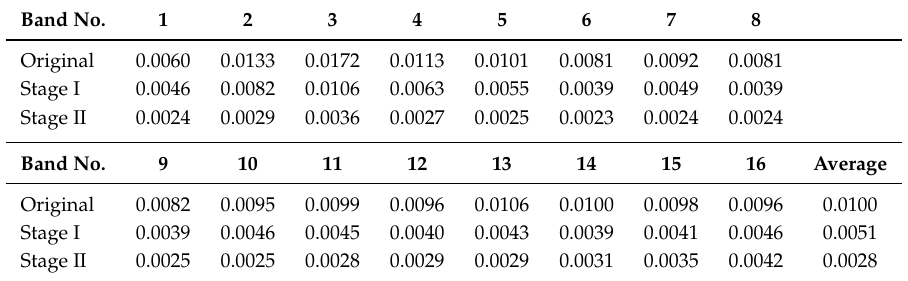
Table 3. Standard deviations of response consistency obtained from the test data when applying the polynomial regression model computed from the training data.